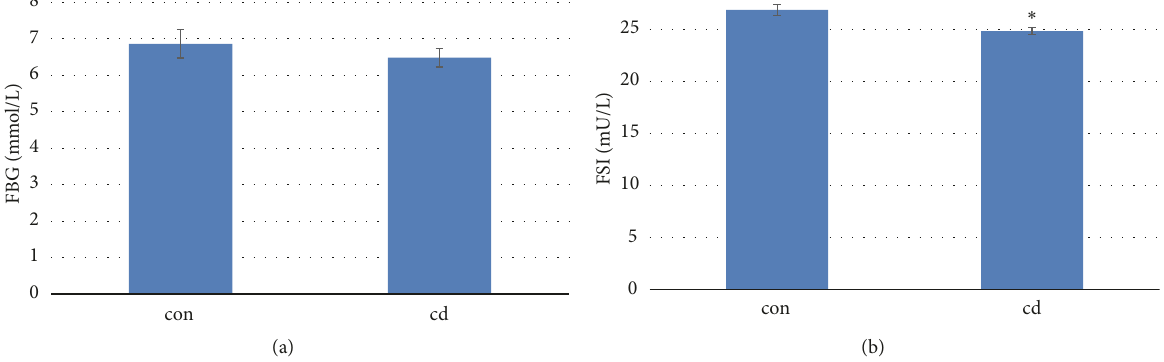
Figure 2: Effects of chronicCd exposureon FBG and FSI (FBG: (a);FSI: (b)) levelsin maleC57BL/6mice.Dataare mean ± SEM (n=5/group). ∗ Significantly different from con and Cd groups, at P < 0.05.